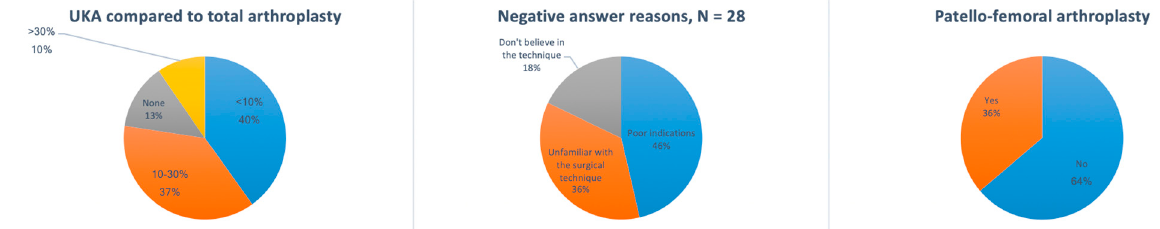
Figure 2. UKA and PFA related data. (N = number of answers).